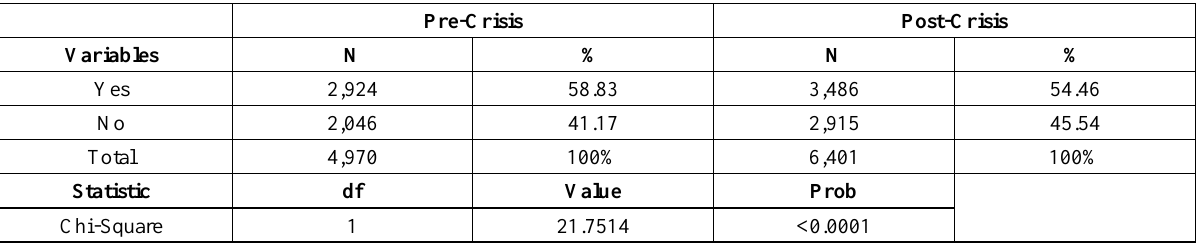
Table 2. Was Visited or Inspected by Tax